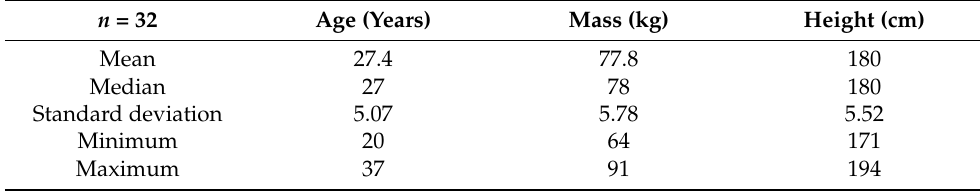
Table 1. Demographic data of study